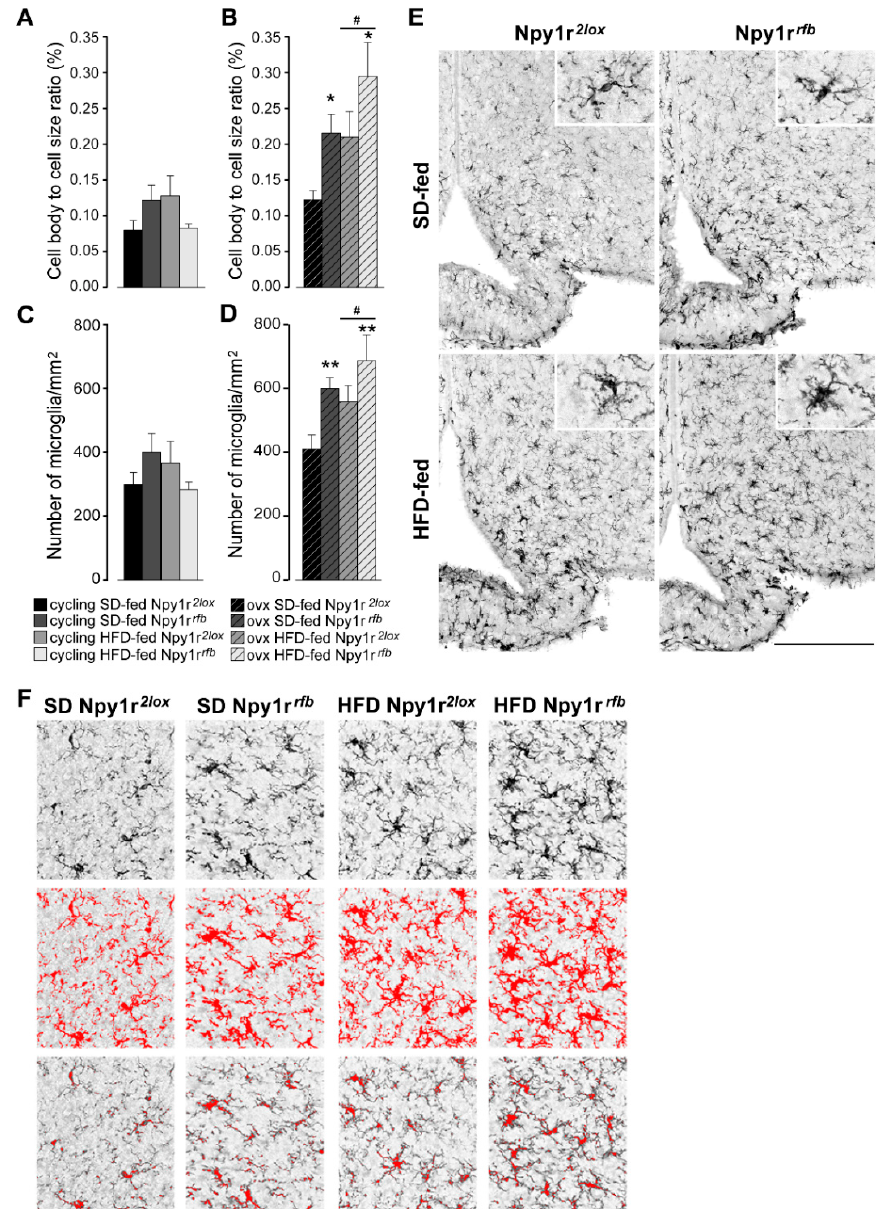
Figure 5. Effect of HFD and Npy1r gene deletion on microglial activation and microglia number. The cell body to cell size ratio (cb/c) of microglia ( A , B ) and the number of microglia/mm 2 ( C , D ). HFD significantly increased cb/c ( B ) and microglia number ( D ) in the ARC of ovx females. Conditional inactivation of Npy1r gene increased cb/c (B) and microglia number ( D ) in the ARC of SD- and HFD-fed ovx mice. Data are the mean ± SEM; n = 4–6 from 2 litters. # p < 0.05 versus SD-fed ovx females. * p < 0.05 and ** p < 0.01 versus Npy1r 2lox ovx females on the same diet regimen. ( E ) Representative images of the ARC of ovx females expressing ionized calcium-binding adaptor protein-1 (IBA-1) immunoreactivity (scale bar: 150 μ m). ( F ) Image analysis used to quantify the morphological characteristics of microglia in Iba-1 staining in ovx females. Upper panels: the unprocessed pictures. Middle panels: pixels darker than the background are traced (red) to determine the total cell size of microglia. Lower panels: pixel-clusters that are above an applied staining threshold and size-filter are traced (red) to determine the total cell body size of all microglia, as well as the number of microglia.